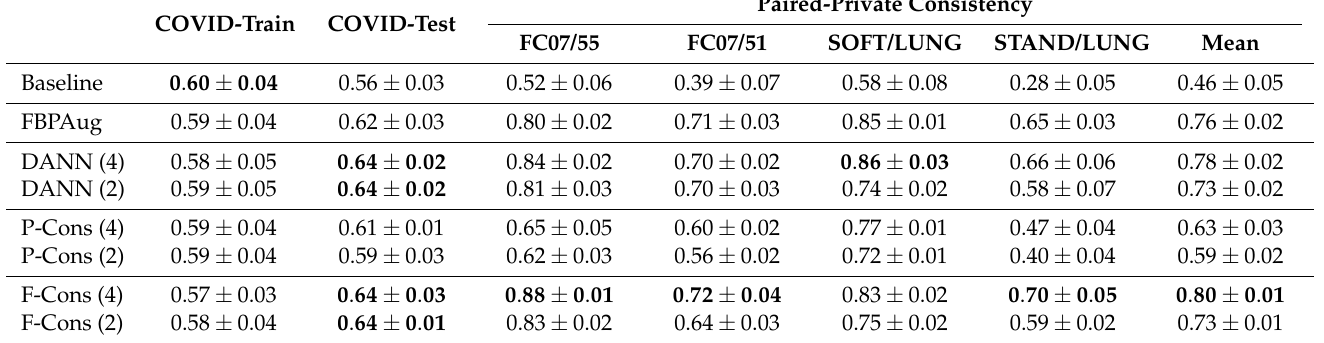
Table 4. Comparison of DANN, P-Consistency, and F-Consistency generalizing to previously unseen SOFT, STANDARD, and LUNG kernels. The numbers in the brackets next to the methods correspond to the number of kernel pairs in the Paired-private dataset they are trained with, e.g., DANN (4) matches with the DANN in Table 3. All results are Dice Scores in the format mean ± std calculated from 5-fold cross-validation.